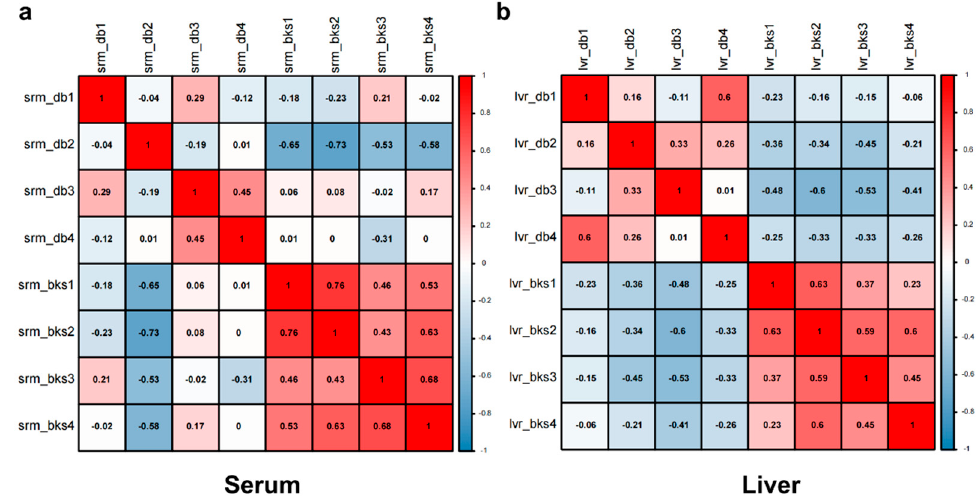
Figure 2. Sample repeatability analysis of quantitative serum total proteins for bks and db / db mice. Pearson’s correlation coefficients of the serum ( a ) and liver ( b ) represented the four repeats of bks mice distinguishing the repeats from db / db mice.